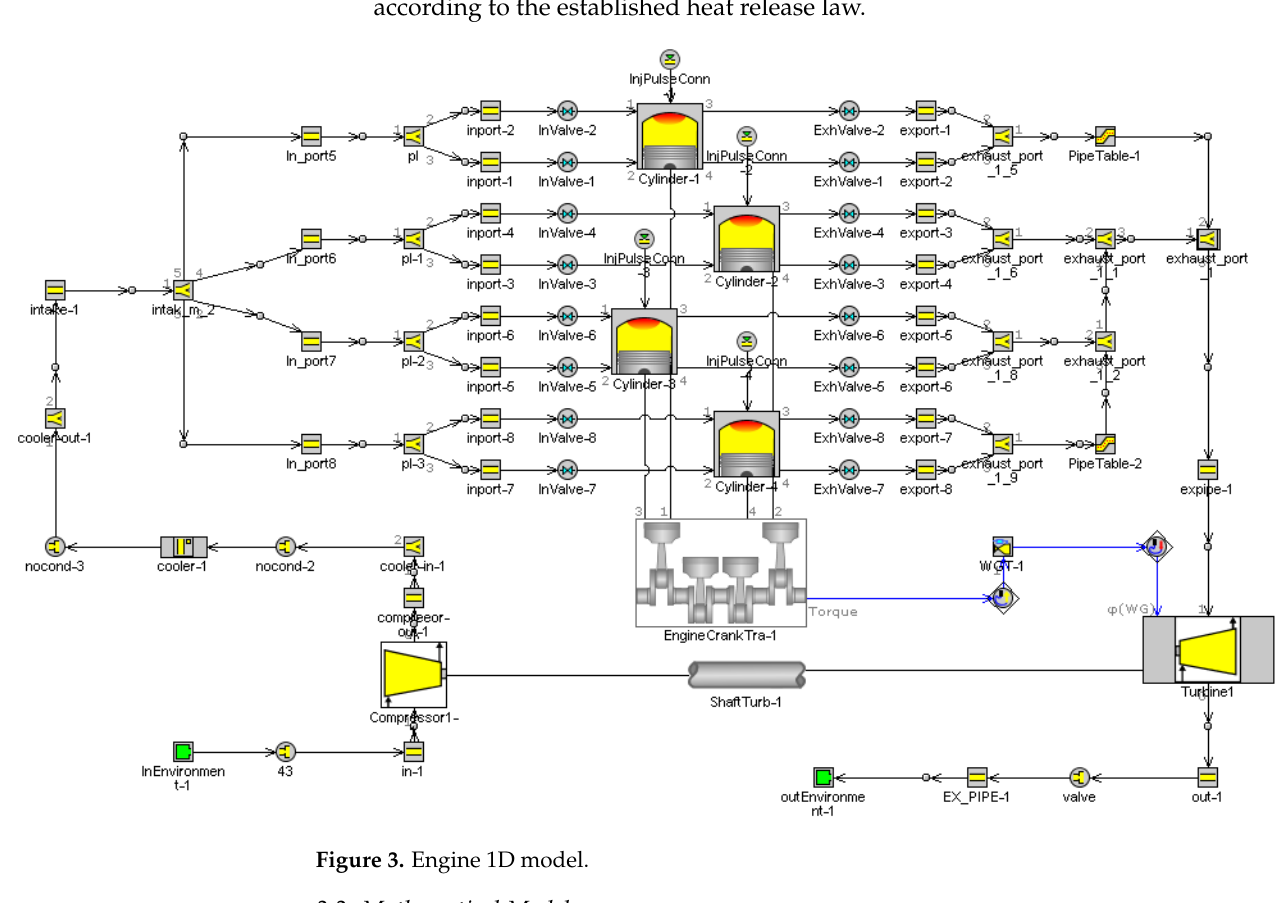
Figure 3. Engine 1D model.